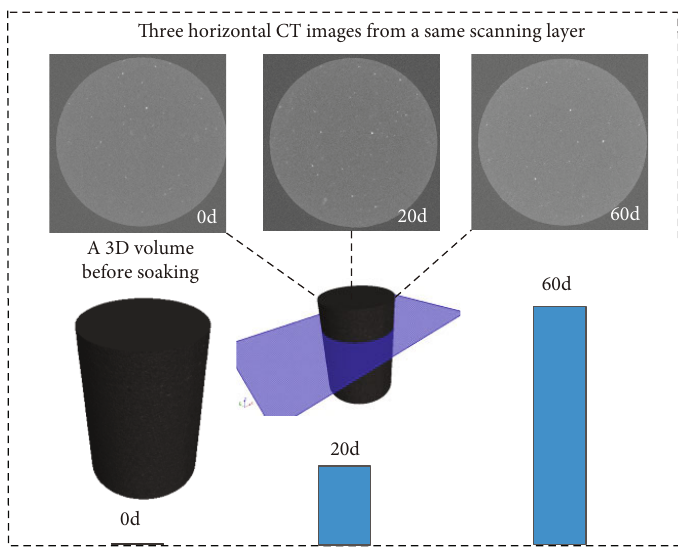
Figure 3: Scanning results of 3D volume before soaking and CT images after three hydration periods of S1.